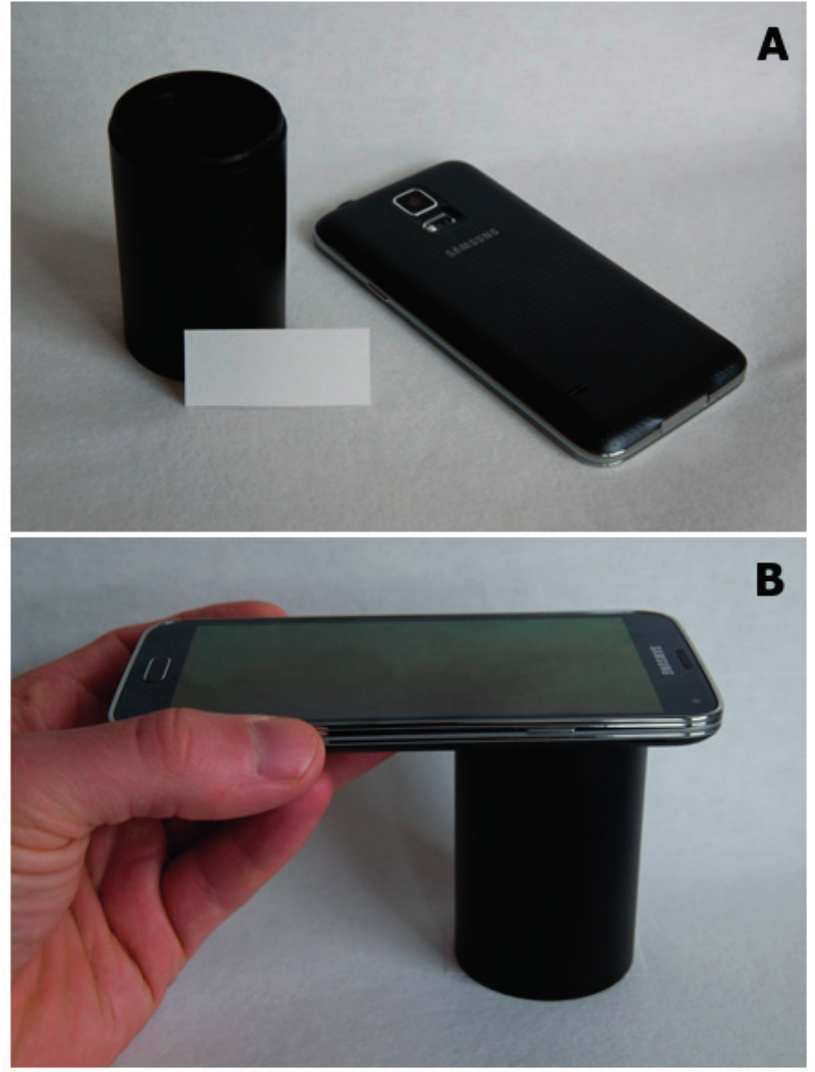
Figure 1. Photos of gear used for the assay. ( A ) Smartphone beside distance tube and paper soaked with indoxylacetate. The camera and LED light source are visible in the photo; ( B ) Setup used for photographing the